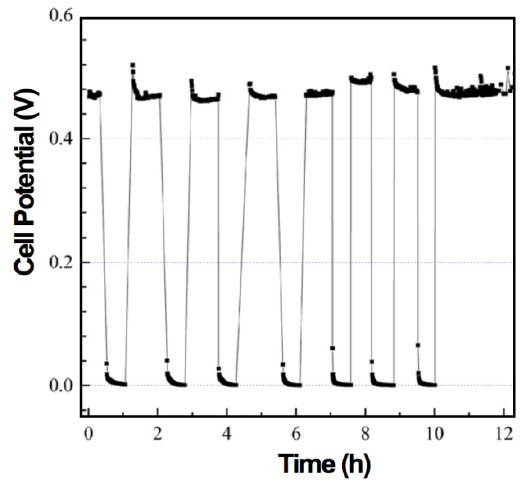
Figure 25. Time dependence of cell voltage of a Sr Ni-Ce Sm O , Ni-YSZ anode and YSZ thin electrolyte over 7 RedOx cycles at 800 °C 0.8 0.2 2 (under fuel, i = 0.9 A/cm 2 ). The cell is alternatively exposed to dry H for 30 min